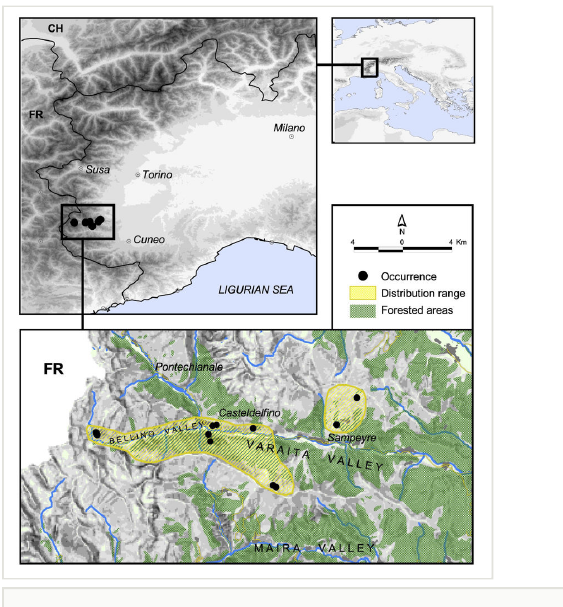
Figure 2. Known distribution of Pimoa delphinica